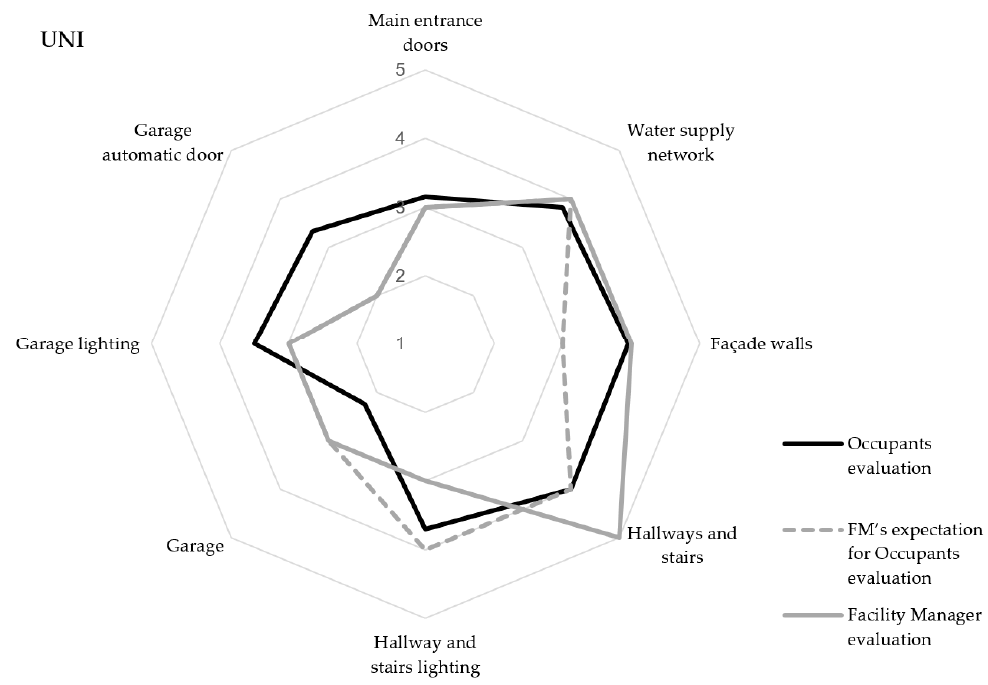
Figure 7. Occupant perception vs. facility manager perception—UNI.